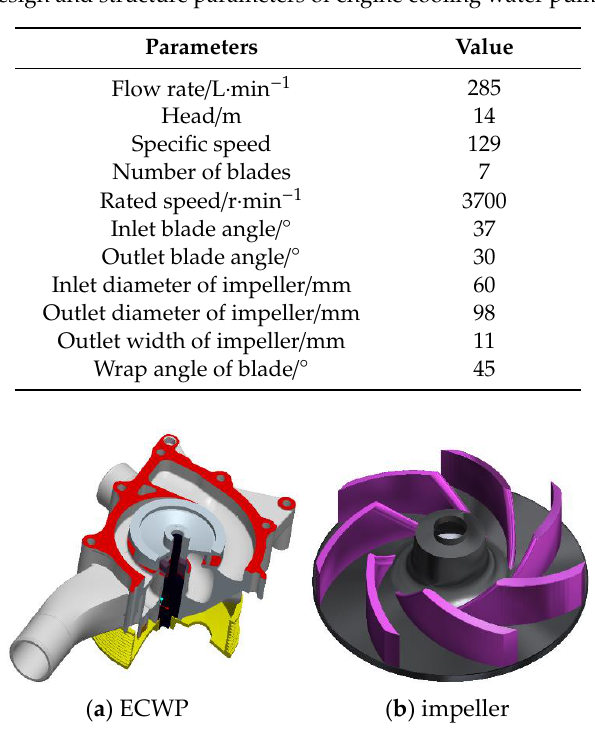
Figure 1. Geometric model of engine cooling water pump.